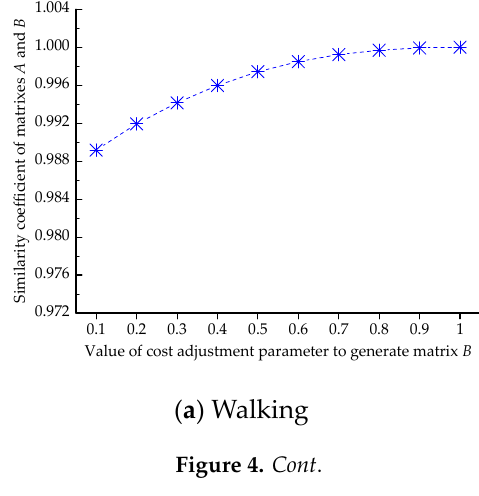
( a ) Walking Figure 4. Cont